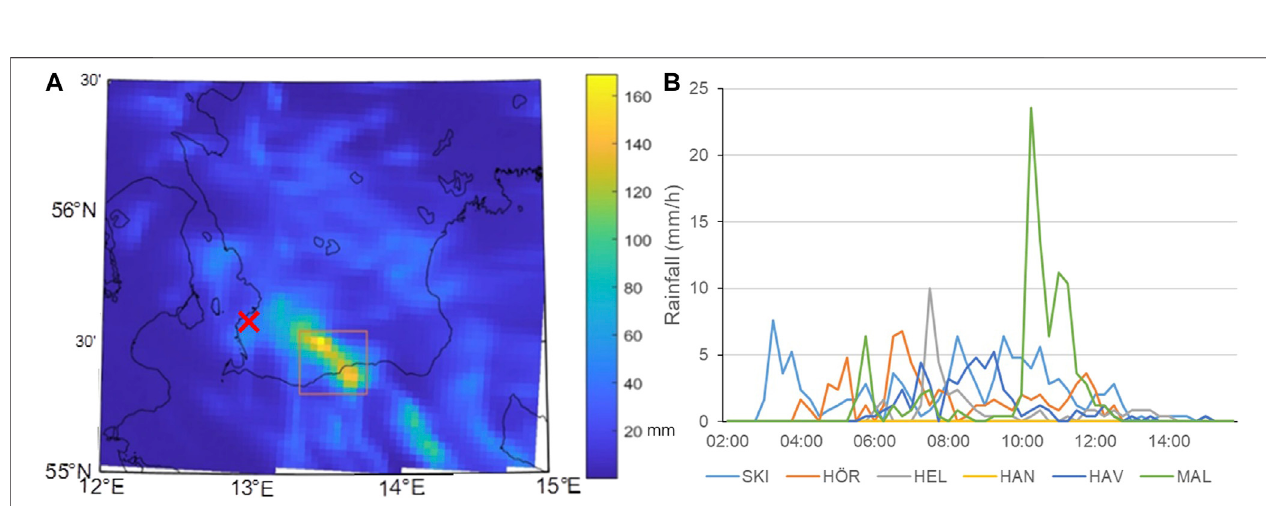
FIGURE9| Accumulatedrainfallbetween02:00and14:00UTCon2002-08-03assimulatedbyHCLIM3 (A) andtherainfallobservationsfromthestationnetwork in the same period (B) . The red cross shows the location of Malmö.